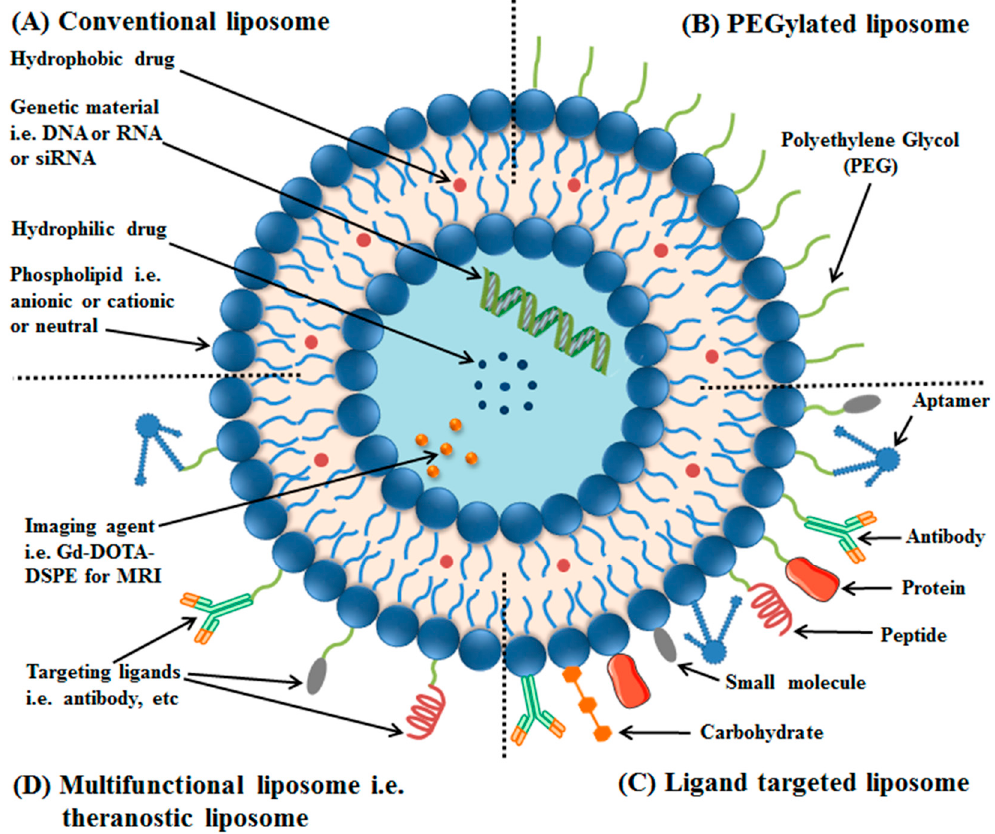
Figure 1. Liposomes: Conventional liposomes are made of phospholipids ( A ); PEGylated/stealth liposomes contain a layer of polyethylene glycol (PEG) at the surface of liposomes ( B ); targeted liposomes contain a specific targeting ligand to target a cancer site ( C ); and multifunctional such as theranostic liposomes, which can be used for diagnosis and treatment of solid tumors ( D ).